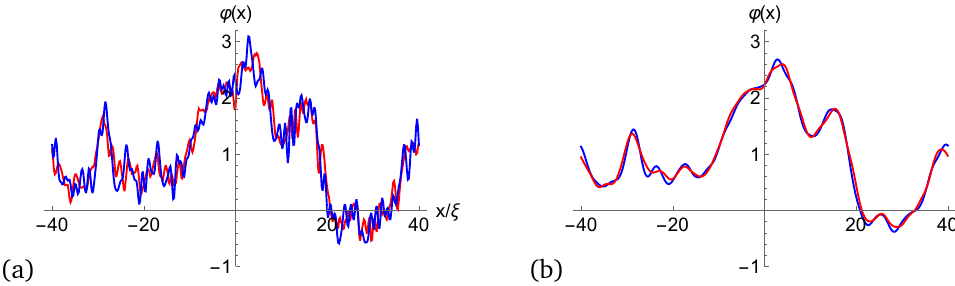
( x ) ( blue ), compared to the a = 4ms and t = 14 ξ/ v . (b) The same 1 0